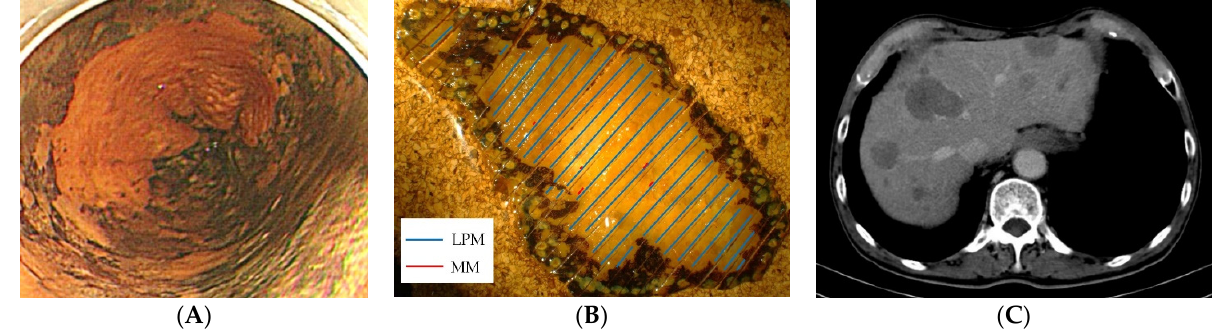
Figure 2. A case of superficial squamous cell carcinoma invading the MM without LVI showed liver metastasis after ER (Case 6). ( A ) The lesion showed a large unstained area under Lugol chromoendoscopy. ( B ) The lesion was endoscopically resected, and the pathology showed squamous cell car-